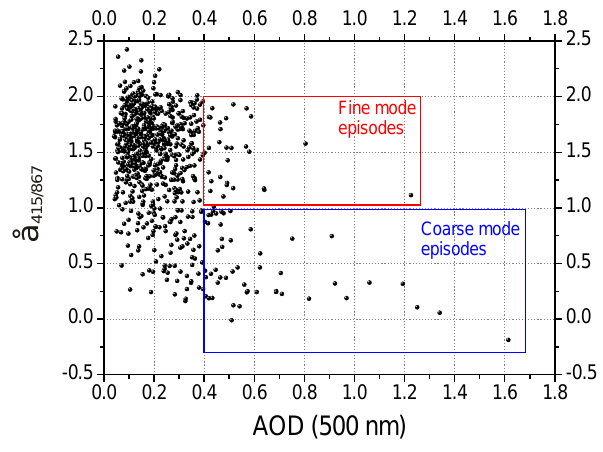
Fig. 3. AOD versus the ˚Angstr¨om coefficient for the period 2006– 2008. High AOD cases ( > 0.4) of fine and coarse particles, respec- tively, have been denoted.